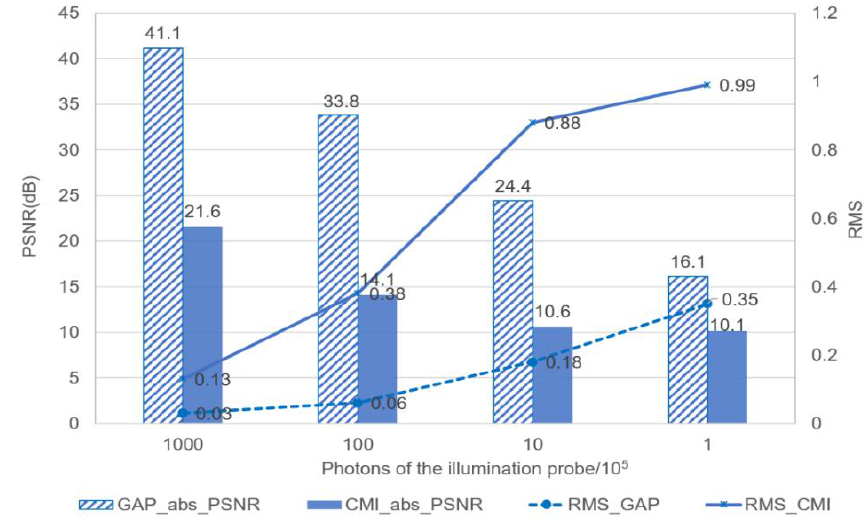
Figure 5. Reconstruction of the sample given far-field CMI simulated data at varying photon flux. In the lower right corner of each image is a larger version of the middle region. CMI-GAP produces significant enhancement on reconstruction quality.